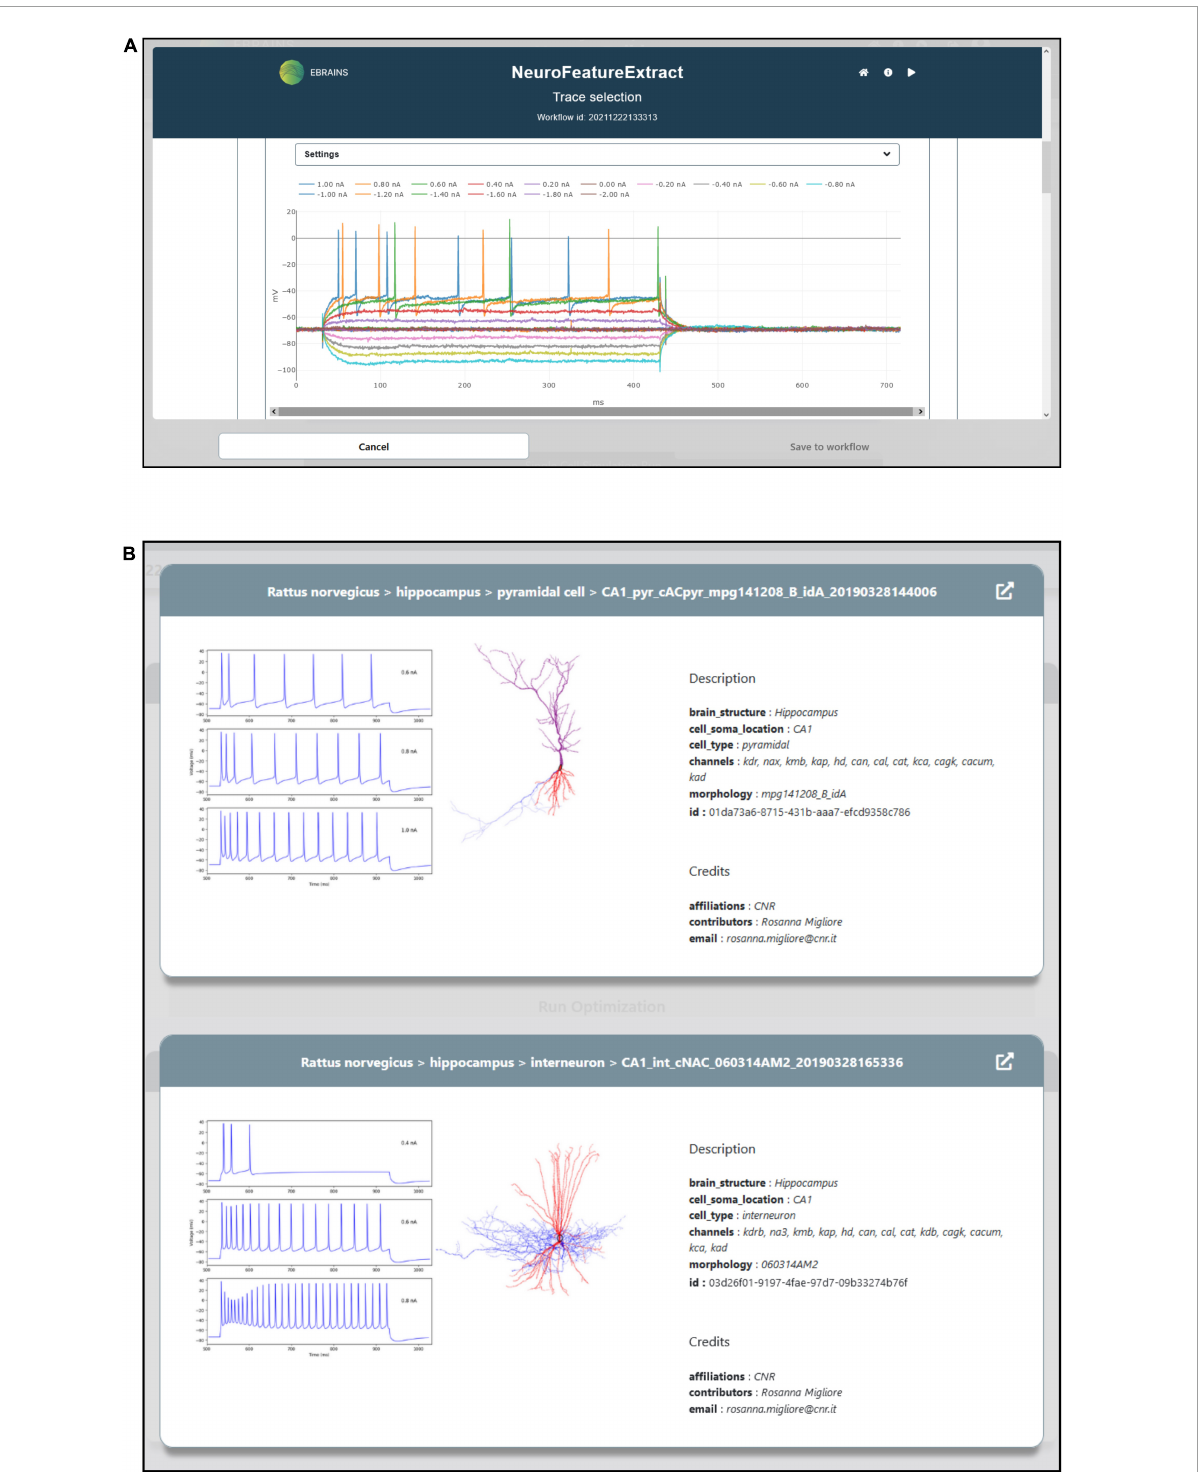
FIGURE3 Feature extraction and model choice interface. (A) The HHNB integrates, in a dedicated window, the NFE web application that allows users to extract the electrophysiological features of interest against which the single cell neural model will be optimized. (B) The model to be optimized can be chosen from a list of models available in the EBRAINS Model Catalog. For each model, a panel is provided where information on the model components and metadata, and representative images of the model morphology and behavior are displayed. In order to access more detailed information about the models, the relative EBRAINS Model Catalog pages can be opened via the top-right arrow